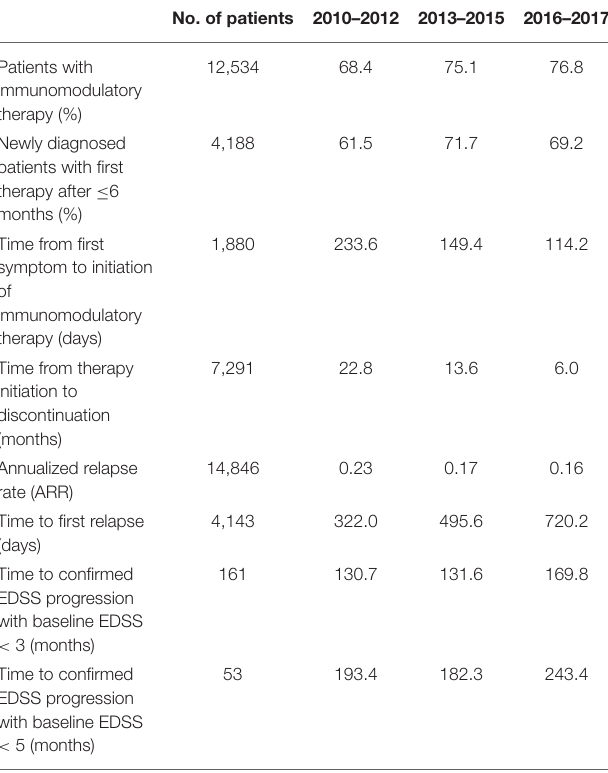
TABLE 4 | Results for clinical parameters.